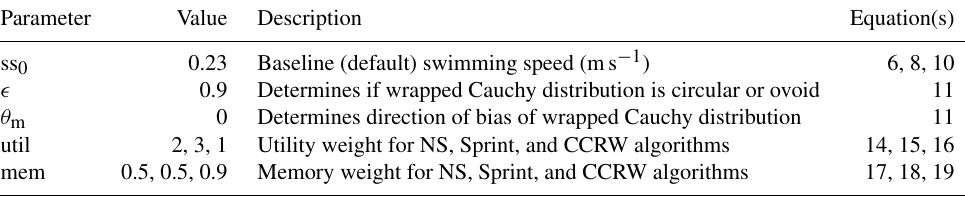
Table 2. Parameter values for the four movement algorithms used to simulate avoidance of low DO and the default behavior of individual fish.